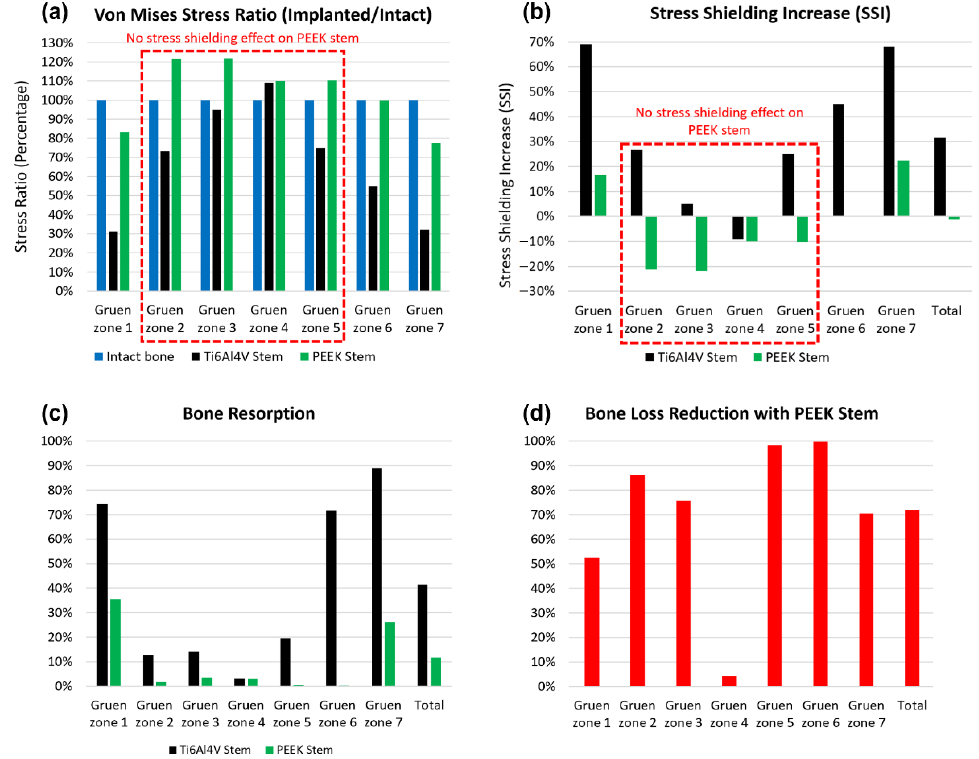
Figure 10. The von Mises stress ratio (a) , stress shielding increase (b) , bone resorption (c) , and bone loss reduction with the PEEK stem compared with the Ti6Al4V stem (d) in each Gruen zone from the Gruen zone 1 to 7.